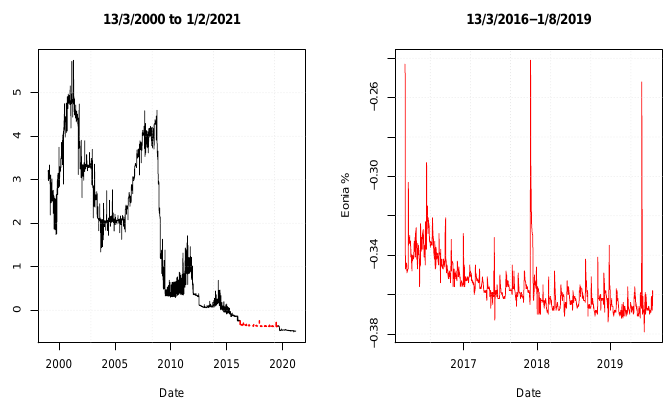
Figure 3. ( Left plot): Eonia time series from 13 March 2000 to 1 February 2021. ( Right plot): dataset used to estimate